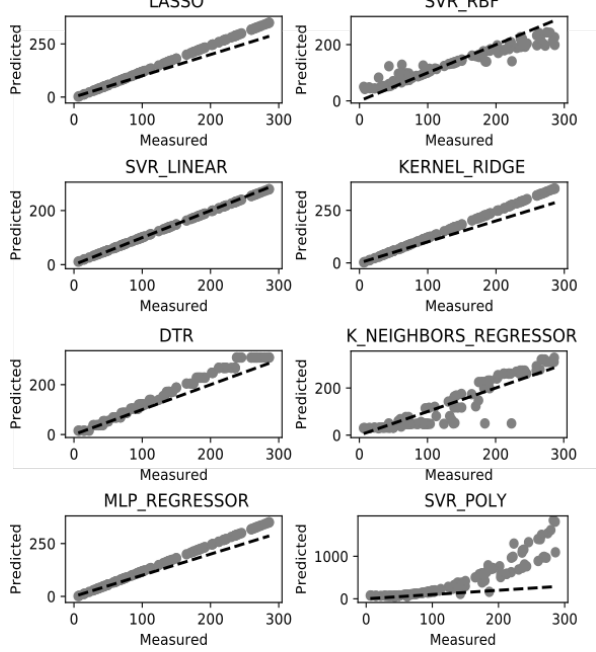
Figure 4. Survival time prediction success